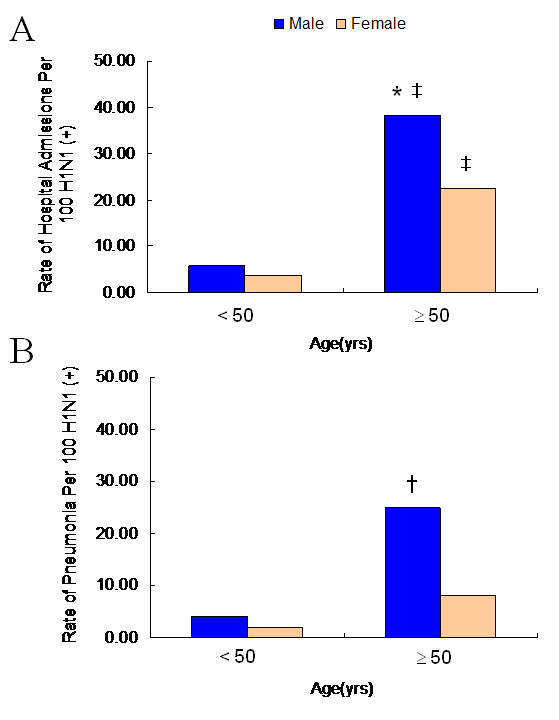
Rate of hospital admission (A) and pneumonia (B) per 100 pandemic influenza A (H1N1)-confirmed cases. Results for both male and female are shown separately for those aged < 50 years old and those aged ≥ 50 years old. Comparisons were made of the rate of hospital admission (*P < 0.001) and pneumonia (†P = 0.0019) between male and female aged ≥ 50. There was a significant difference of the rate of admission between aged < 50 years old and aged ≥ 50 years old in both sexes (‡P < 0.001).